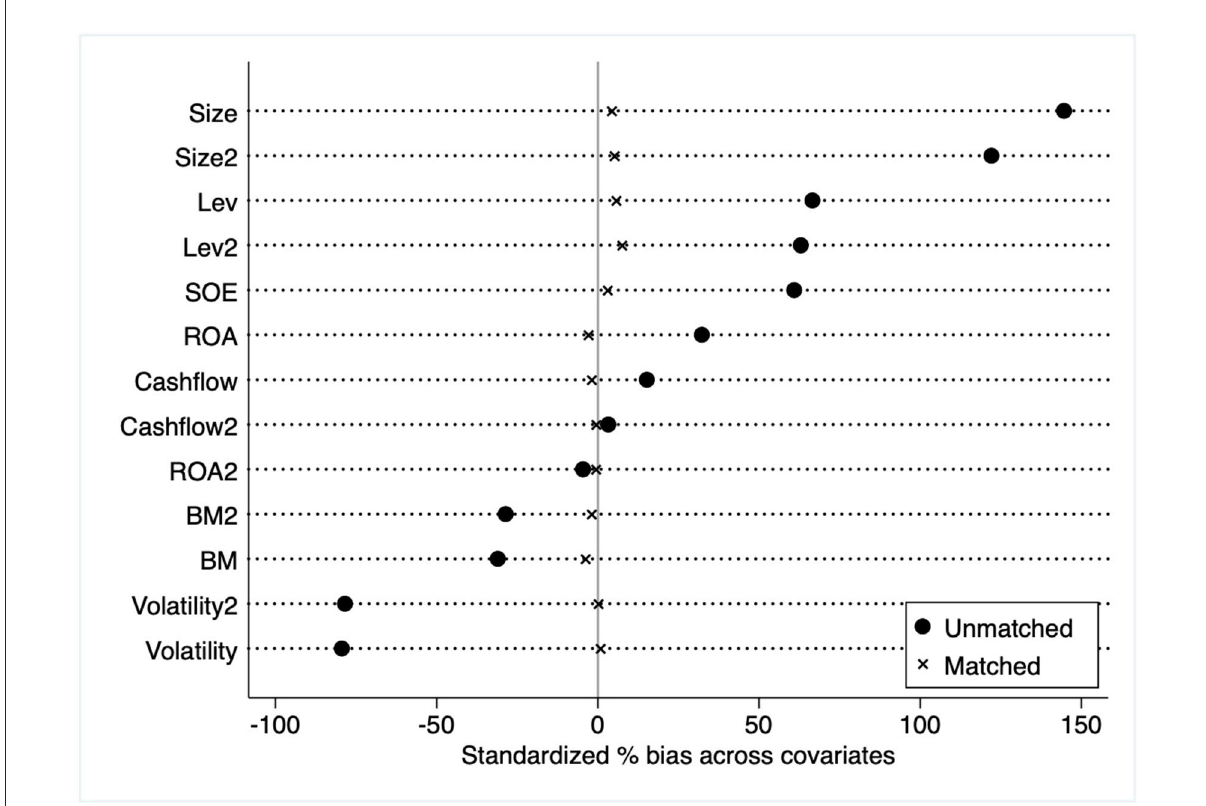
FIGURE1 Covariates balance test, unmatched vs. matched. The Y-axis in the figure is the covariates entering the propensity index model, including the control variables (e.g., Volatility, Lev, ROA, Cashflow, Size, and BM) and their square terms (e.g., Volatility2, Lev2, ROA2, Cashflow2, Size2, and BM2) and the type of ownership (SOE). The X-axis is the standardized bias across